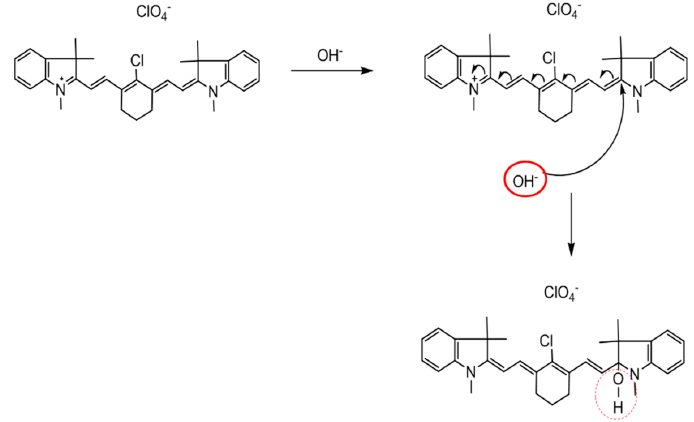
Scheme 2. Schematic depiction of nucleophilic addition of OH ´ to